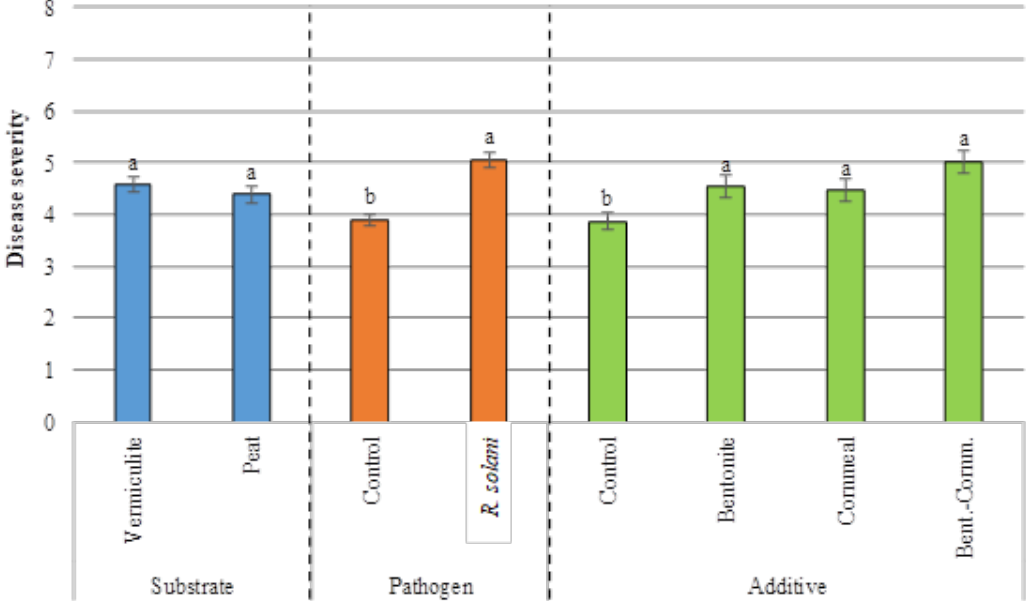
Figure 2. Disease severity in aerial part at 45 days after sowing for substrates, pathogen and additives. Disease severity scale: 1, without chlorosis; 2, 1%–10% of the leaves with chlorosis; 3, 11%–25% of the leaves with chlorosis; 4, 26%–50% of the leaves with chlorosis; 5, more than 50% of the leaves with chlorosis; 6, plant of bean without leaves; 7, dead plant of bean; 8, dead plant after the germination. Blue colour represents the substrates; orange colour represents the presence or absence of R. solani ; green colour represents the types of additives. Bars of the same colour followed by di ff erent letters are significantly di ff erent ( p ≤ 0.01).